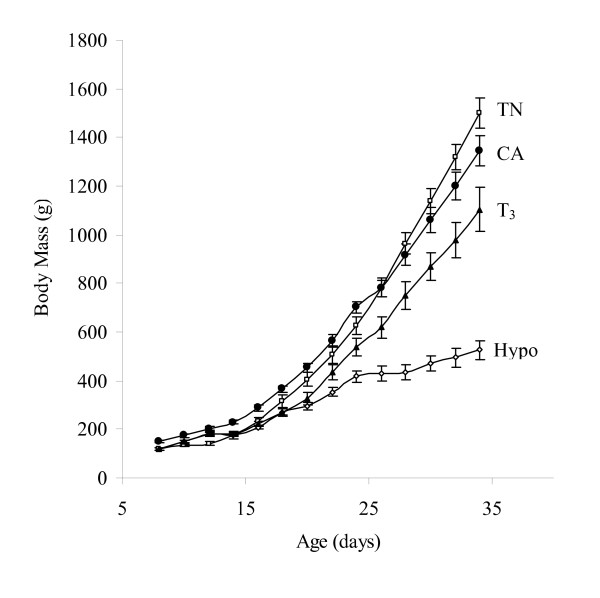
Growth curves of thermoneutral controls (TN), cold-acclimated (CA), hypothyroid (hypo) or T3-treated ducklings. Values are mean ± S.E.M. from 7-9 birds per group.